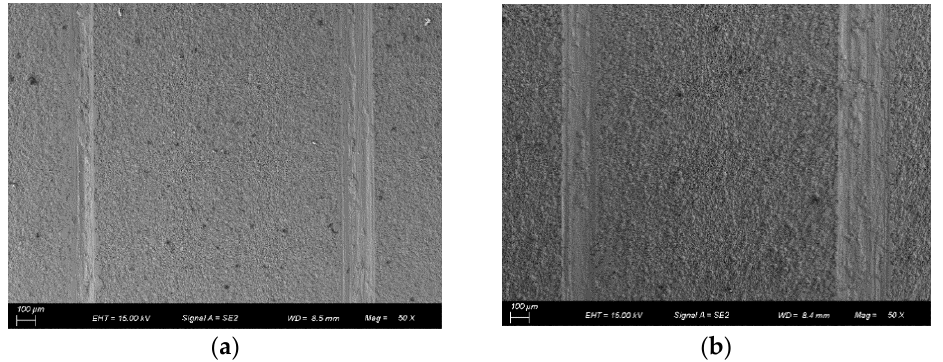
Figure 3. Frictional morphology of the composite coating prepared under two different electrodeposition conditions: ( a ) Sample 1 and ( b ) Sample 2.